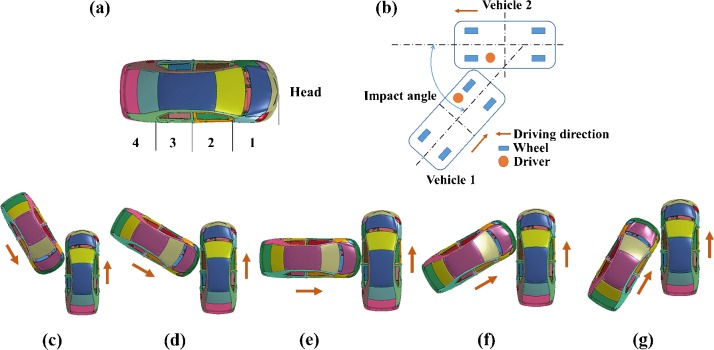
Impact scenario parameters with (a) four impact positions, (b) schematic diagram of impact angle in CVCC situation, impact angles of numerical simulations are (c) 30o, (d) 60o, (e) 90o, (f) 120o, (g) 150o, respectively.